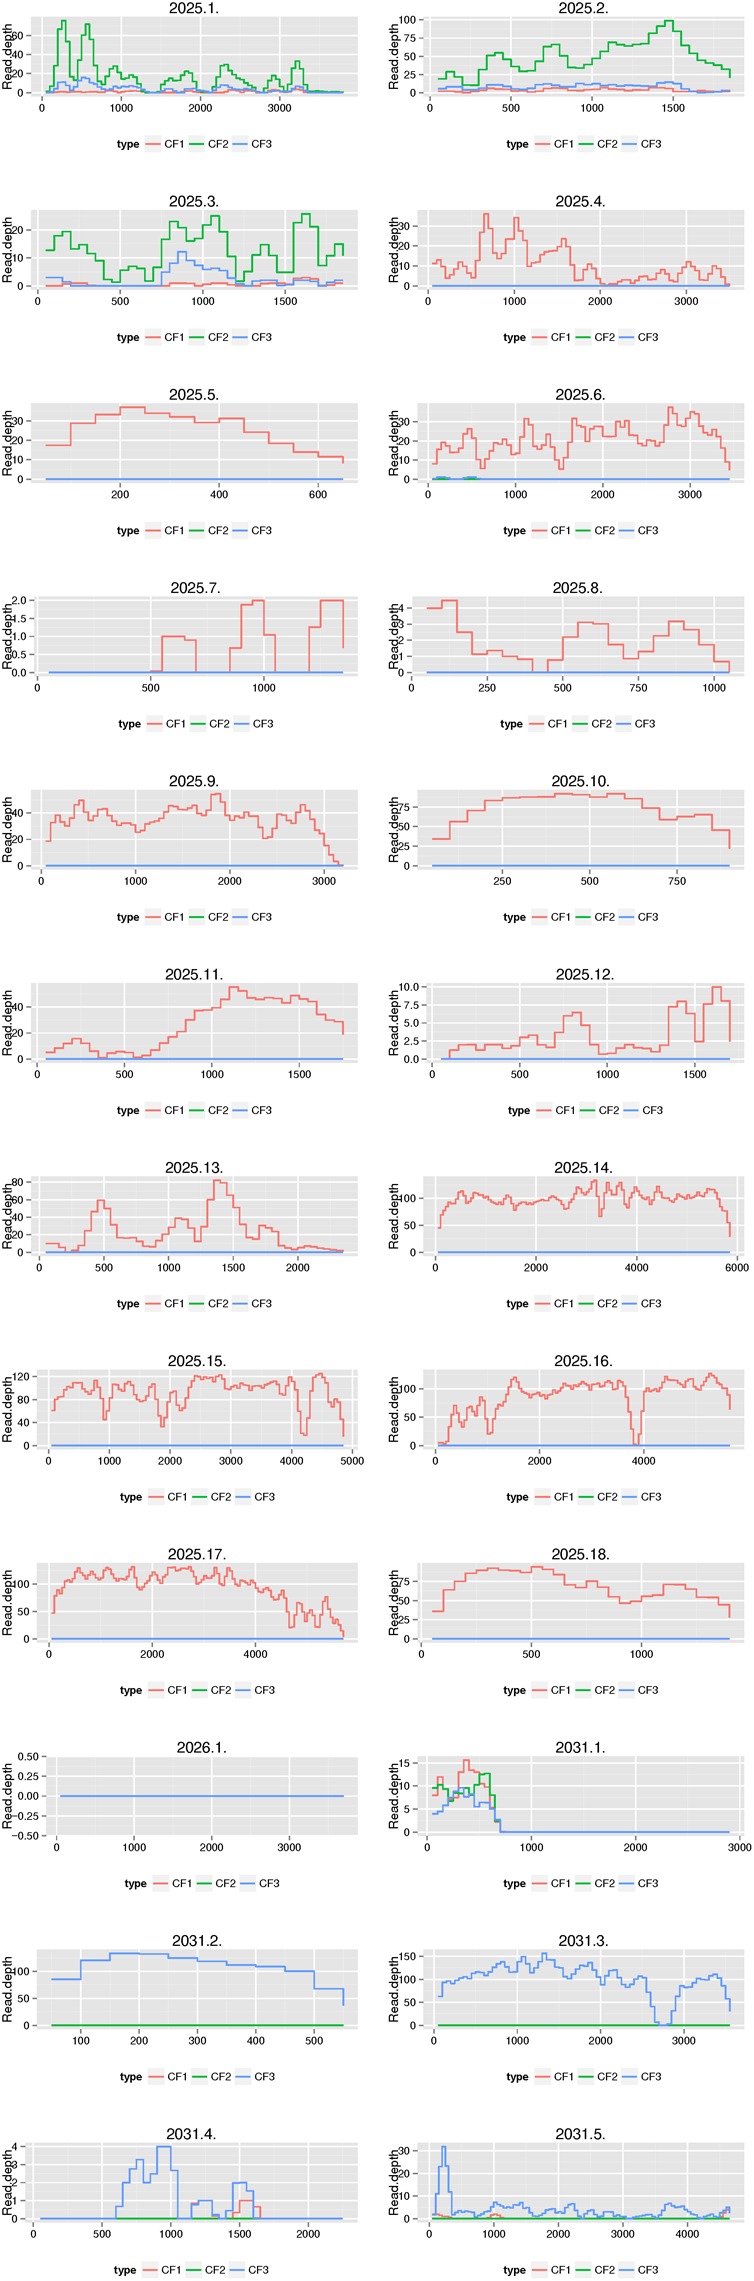
Comparison of the functional resistome with shotgun metagenomics sequencing for three samples. Functional resistome analyses revealed 18 genes for sample ID CF1 (2025.1–2025.18), 1 gene for CF2 (2026.1) and 5 genes for CF3 (2031.1-2031.5). The plots illustrate the sequence coverage from the shotgun sequencing for the genes identified by functional genomics. We recovered reads from shotgun metagenomics sequencing for 18/18 (for ID 2025), 0/1 (for ID 2026), and 5/5 (for ID 2031) resistance genes. Certain resistance genes (e.g., 2025.1, 2025.2, and 2025.3) were found in multiple samples [indicated as CF1 (ID 2025), CF2 (ID 2026) and CF3 (ID 2031)].